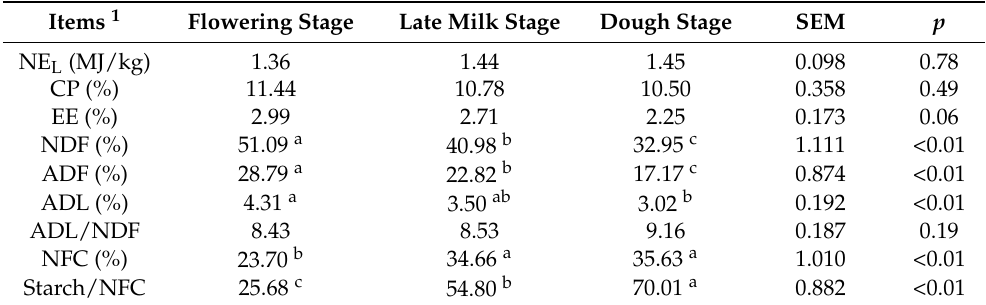
Table 1. The nutrient content of whole wheat hay harvested during three different maturity stages (DM basis).